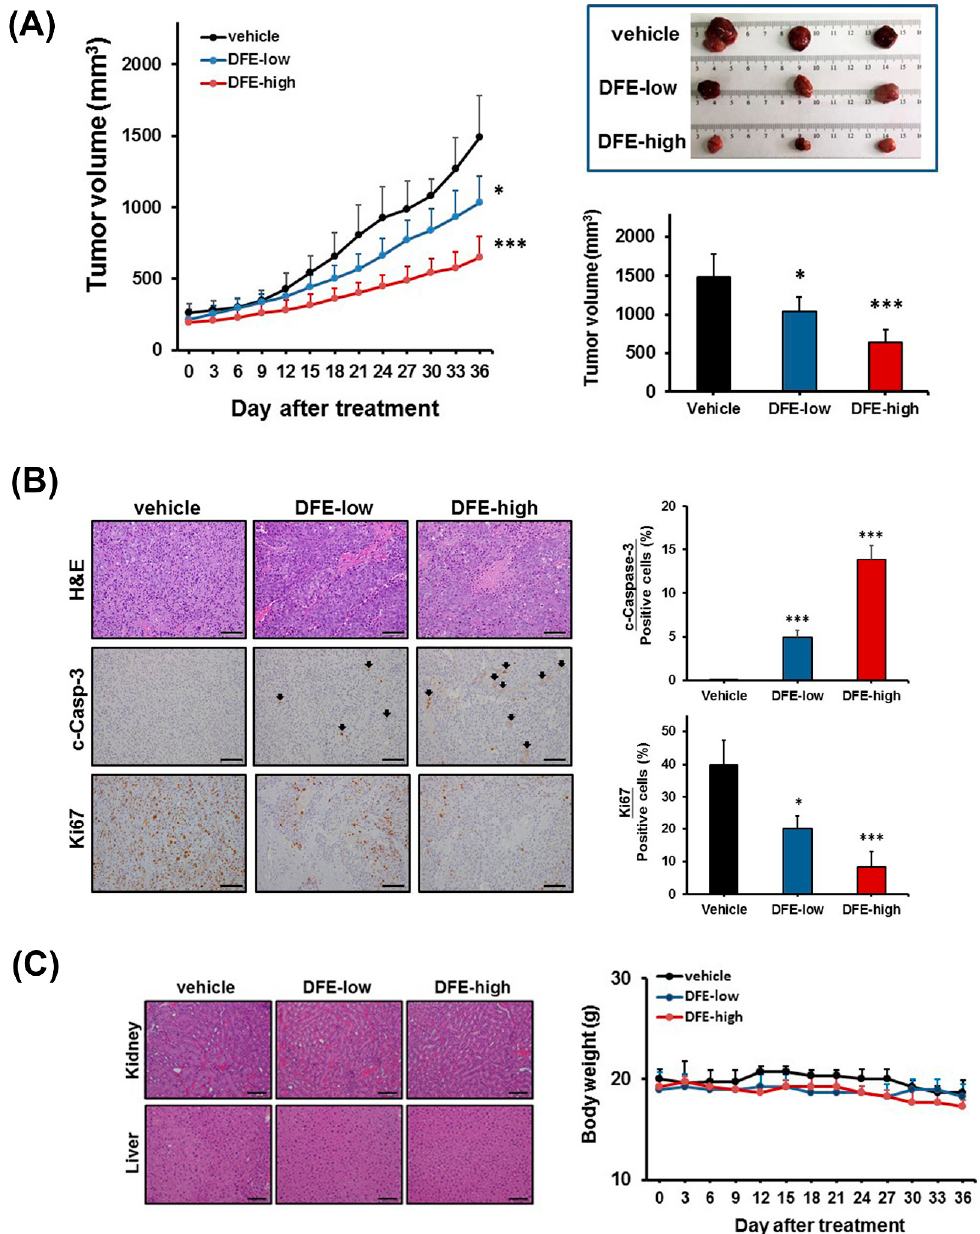
Figure 6. DFE displays anti-PCa activity in vivo. ( A ) DFE (250 (low) and 500 (high) mg/kg body weight) significantly inhibited the growth of subcutaneous C4-2 tumors compared to the control-vehicle group for 36-day observation. The tumor volumes (mm 3 ) showed as the mean ± SD ( n = 5/group). * p < 0.05, *** p < 0.001. Photographs of representative tumors in each group (Day 36) were shown (top-right panel). ( B ) Immunohistochemical (IHC) staining showed that significant increase of cleaved (c)-caspase-3 (c-Casp-3) and decrease of Ki67 were found in the DFE-treated C4-2 tumors compared to the vehicle groups. Scale bar = 100 µm. Quantifications of c-Caspase-3 and Ki67 were analyzed by the positive stained cell counting in an average of five various fields. * p < 0.05, *** p < 0.001. ( C ) Hematoxylin & Eosin (H&E) staining of both the kidney and liver specimens harvested from the vehicle and the DFE C4-2 tumor-bearing mice (left panel). Scale bar = 100 µm. Besides, no apparent di ff erences were found in the body weights among these three groups during the 36-day treatment (right